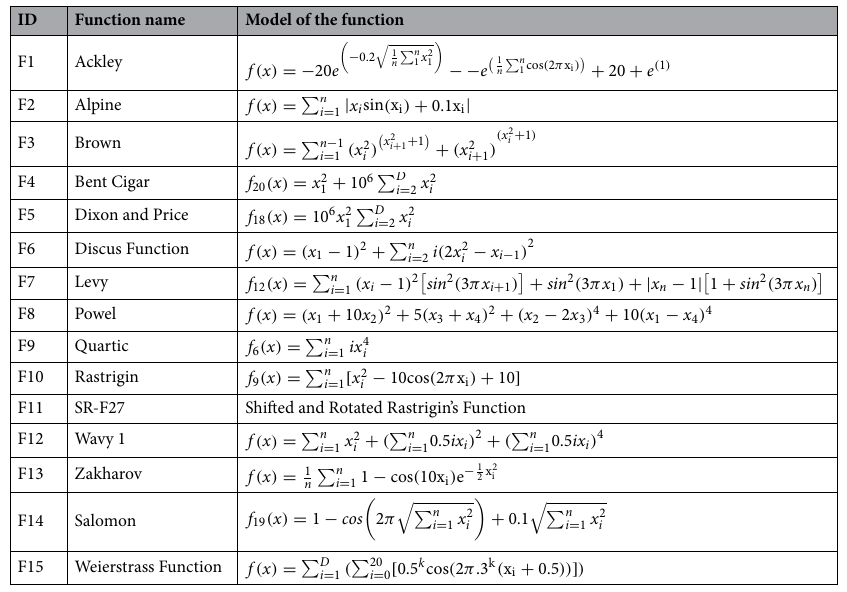
Table 6. Standard and CEC benchmark functions used for the experimentation in evaluating the performances of EOSA, ABC, WOA, PSO and